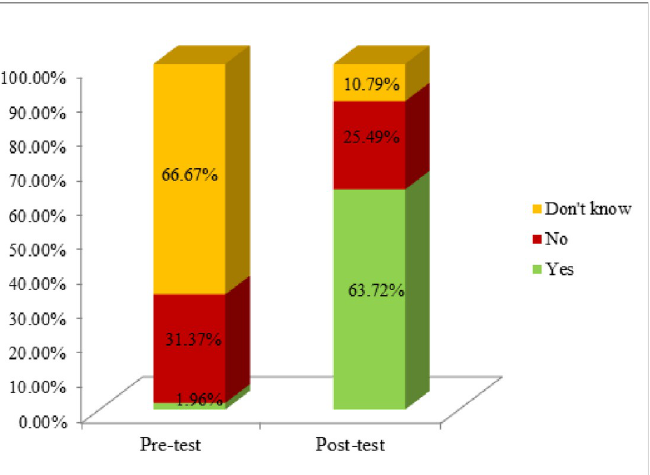
Fig 1. Comparison of participants based on their knowledge about HPV vaccination before and after the intervention (n = 102).